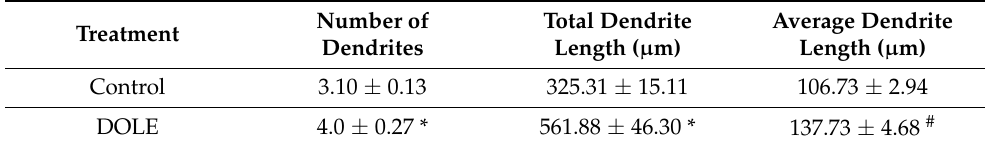
Table 2. Dendricity parameters in HEMn-MP cells after treatment with DOLE at 200 µ g/mL for 48 h. Treatment